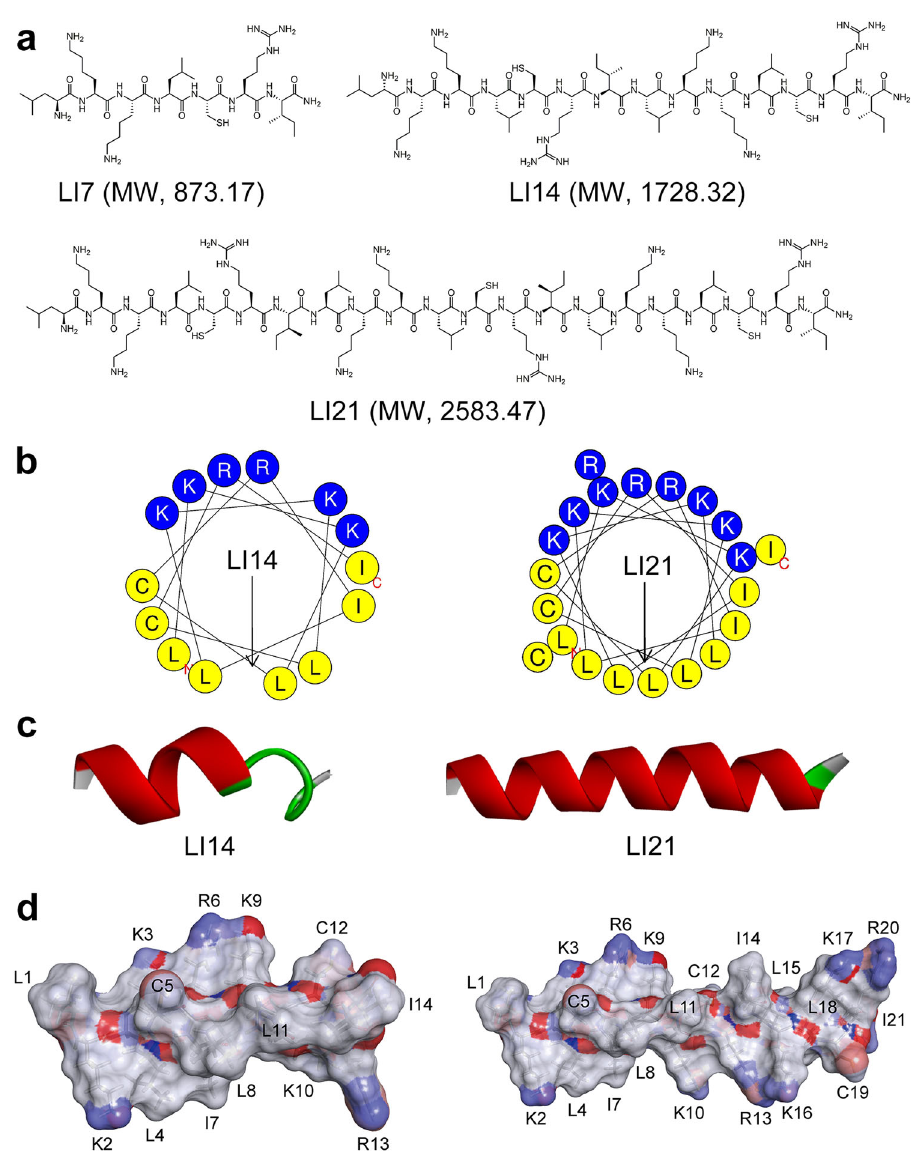
Fig. 1 Design and characterization of novel antimicrobial peptides. a Chemical structures of three LI peptides. b Helical wheel projections of peptides using HeliQuest analysis (http://heliquest.ipmc.cnrs.fr/cgi-bin/ComputParamsV2.py). Amino acids in blue are positively charged, while in yellow are hydrophobic. The length of the arrow represents the relative hydrophobic moments in the fi gure, which are positively correlated. c Three-dimensional structure projections of peptides. I-TASSER (http://zhanglab.ccmb.med.umich.edu/I-TASSER/) was used to forecast the three-dimensional structure projection of LI14 and LI21 peptides. The different colors represent various secondary structure types: red, helix; green, turn; gray, coil. d Potential surfaces of LI14 (left) and LI21 (right)